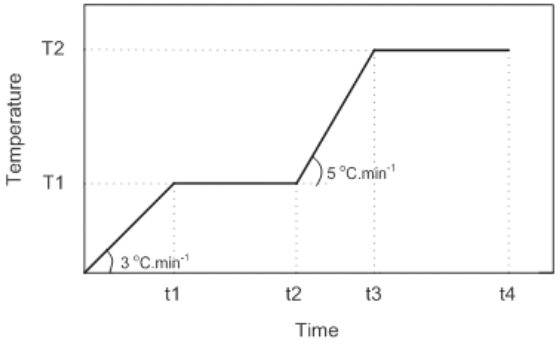
Figure 2 - Temperature profile for the production of activated carbon from jute